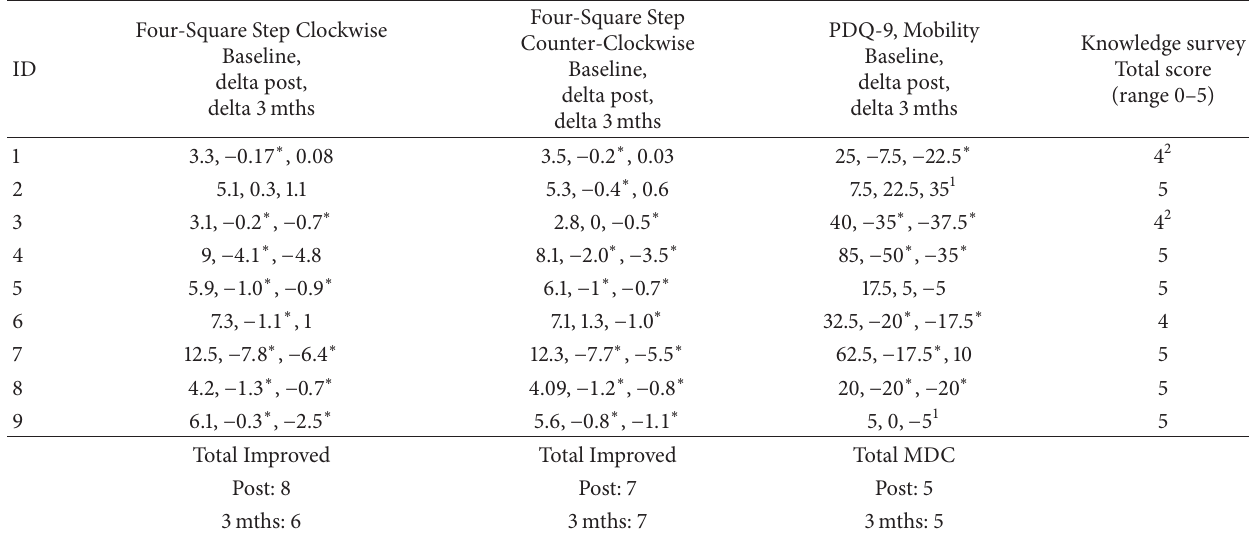
Table 5: Secondary